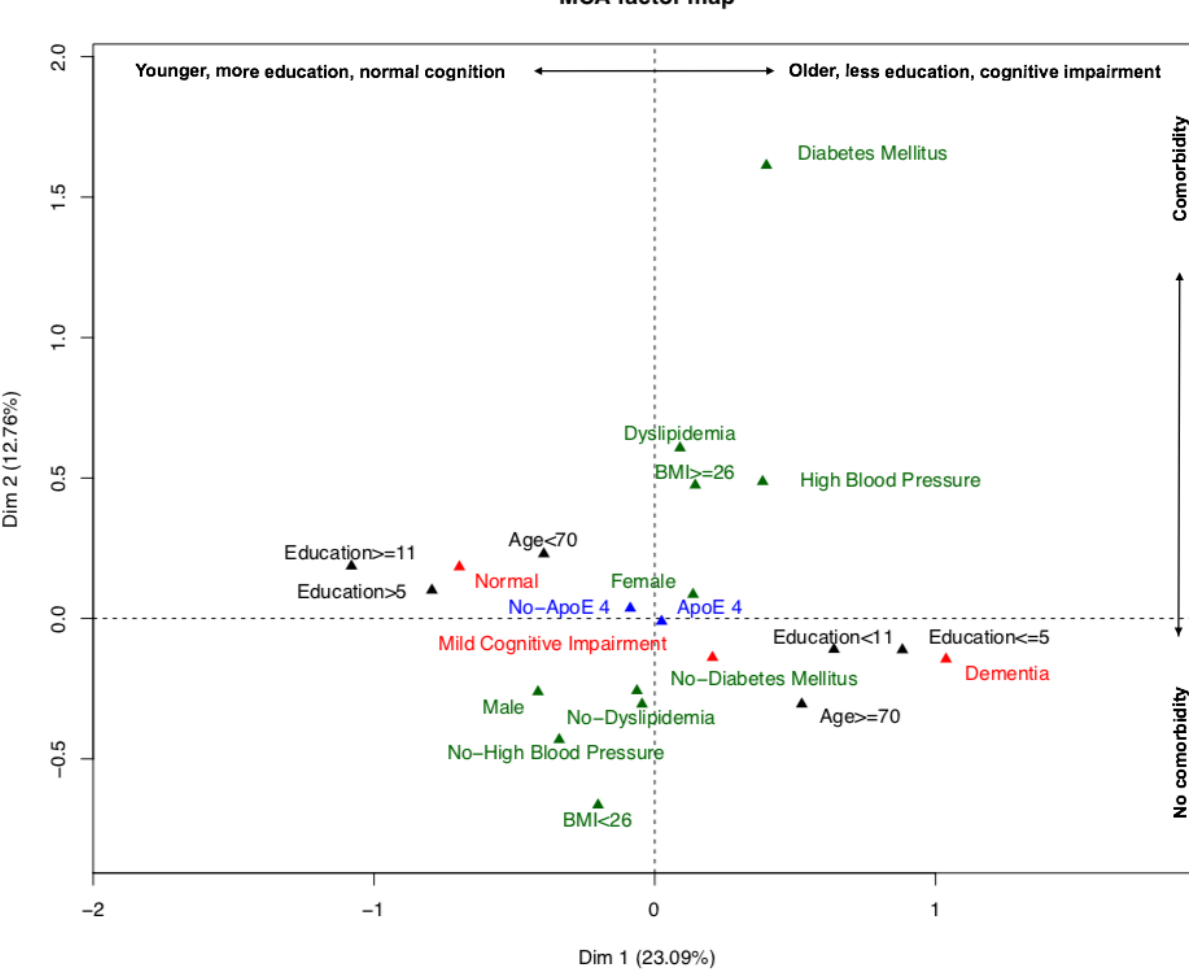
Figure 2. Factorial plane representing the relationship between risk factors, cognitive impairment, and condition of the allele ε